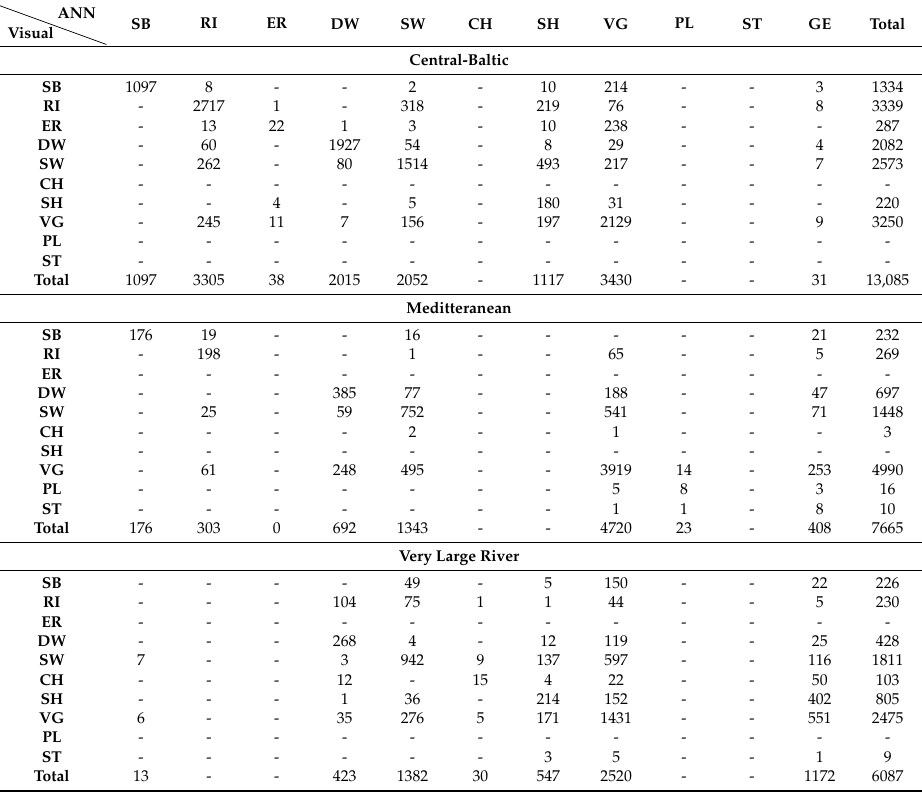
Table 7. Confusion matrix obtained per Geographical Intercalibration Group (GIG) site and feature considered. The features identified are described in Table 4 and are as follows: Side Bars (SB), Riffles (RI), Erosion (ER), Deep Water (DW), Shallow Water (SW), Chute (CH), Shadow (SH), Vegetation (VG), Pollution (PL), Structure (ST) and Georeferencing Error (GE). ANN refers to the features identified with the Artificial Neural Network algorithms. Visual refers to the features identified through visual observation and considered to be the ground truth data